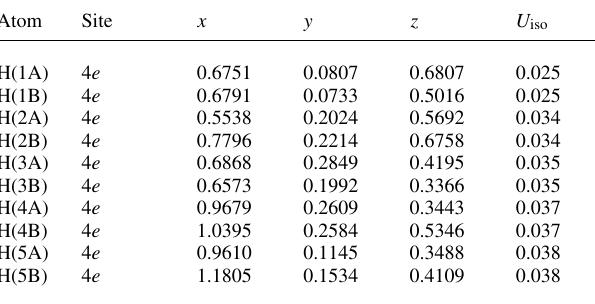
Table 2. Atomic coordinates and displacement parameters (in Å 2 )